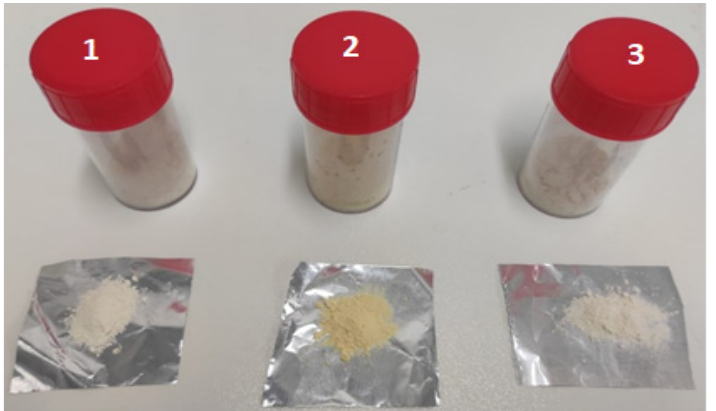
Figure 2. Macroscopic appearance of some microparticle samples obtained from the spray-drying process: 1 (batch A1); 2 (batch B2); 3 (batch C3).